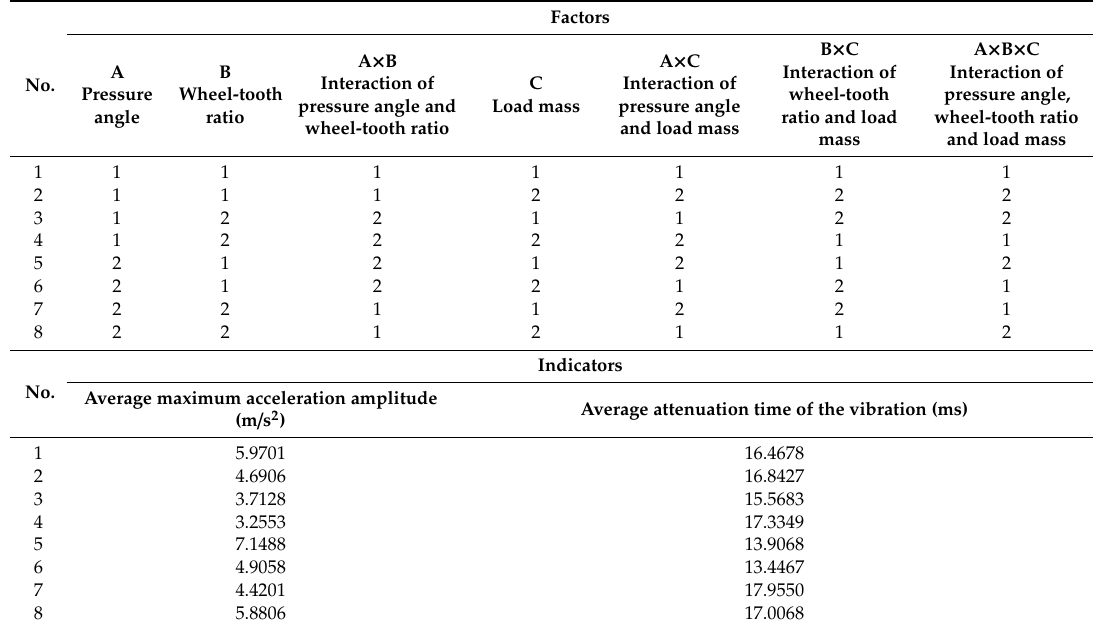
Table 5. Orthogonal Test